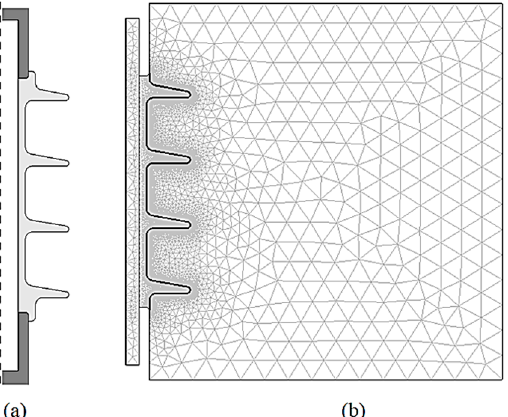
Figure 5. ( a ) A 2D symmetrical insulator model and ( b ) Mesh discretization of the domain problem.